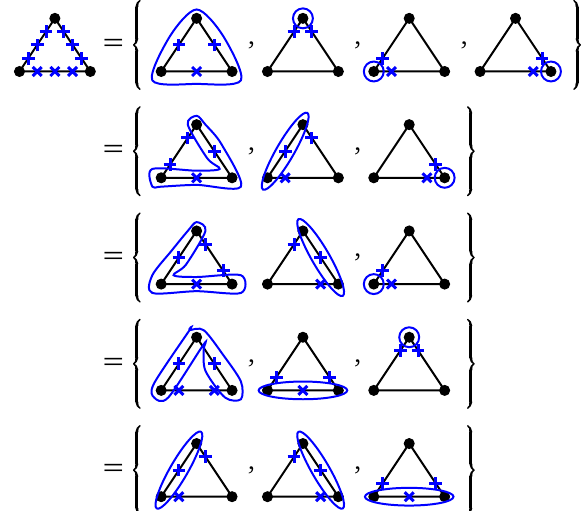
. They can be G + n subgraphs which completely s e